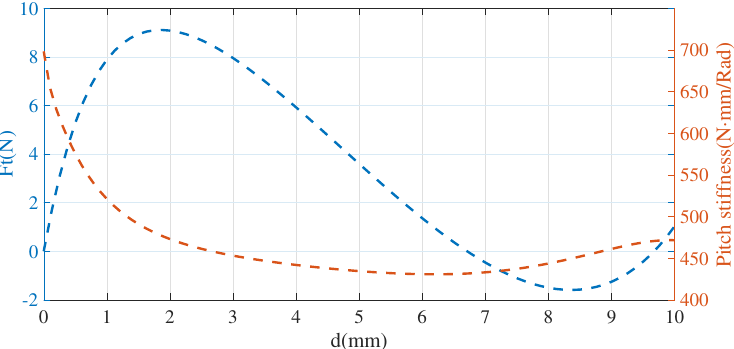
Figure 11. Pitch stiffness − displacement curve of CBBM.